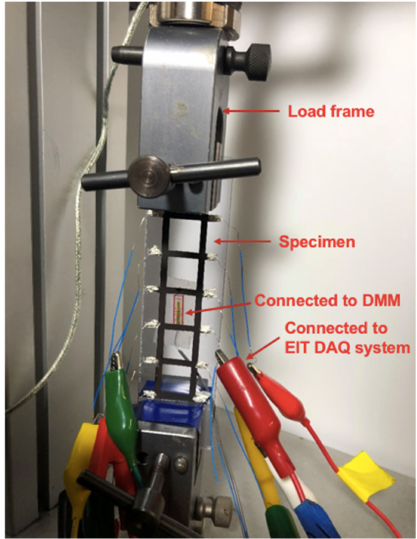
Figure 4. The entire specimen was mounted in the load frame and subjected to uniaxial tensile loading. ERT measurements were collected at different loading states and then used as the inputs of ERT conductivity reconstruction analysis. The magnitude of strain induced in the specimen was recorded by the strain